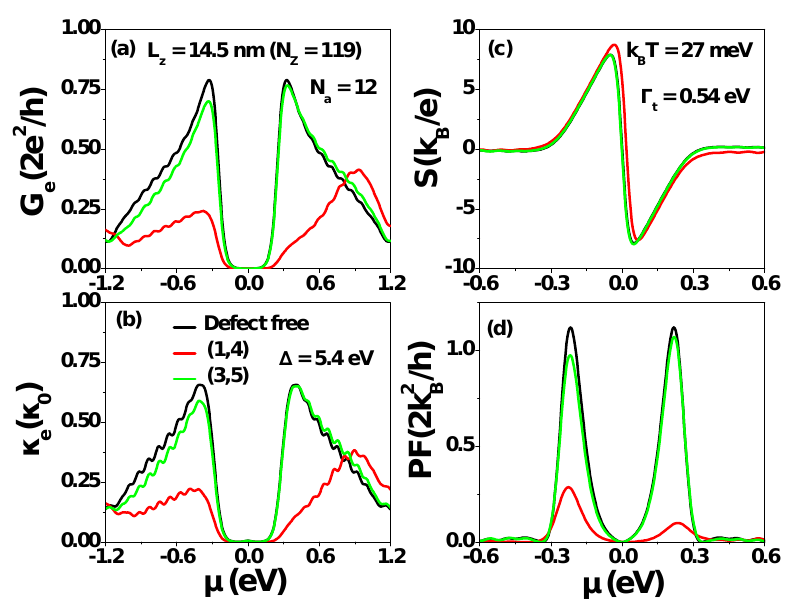
Figure 4. ( a ) Electrical conductance G e , ( b ) electron thermal conductance κ e , ( c ) Seebeck coefficient S , and ( d ) power factor PF = S 2 G e as functions of µ for defect locations at k B T = 27 meV. The tunneling rates used are Γ t = 0.54 eV. The length of SGQD is L z = 14.5 nm ( N z = 119). Each GQD in the SGQD structure has size N a = 12 and N z =